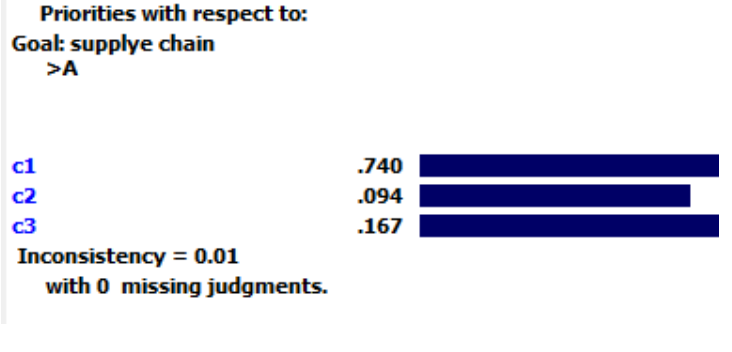
Fig. 3. Step 3: obtain the weight of the indicators.